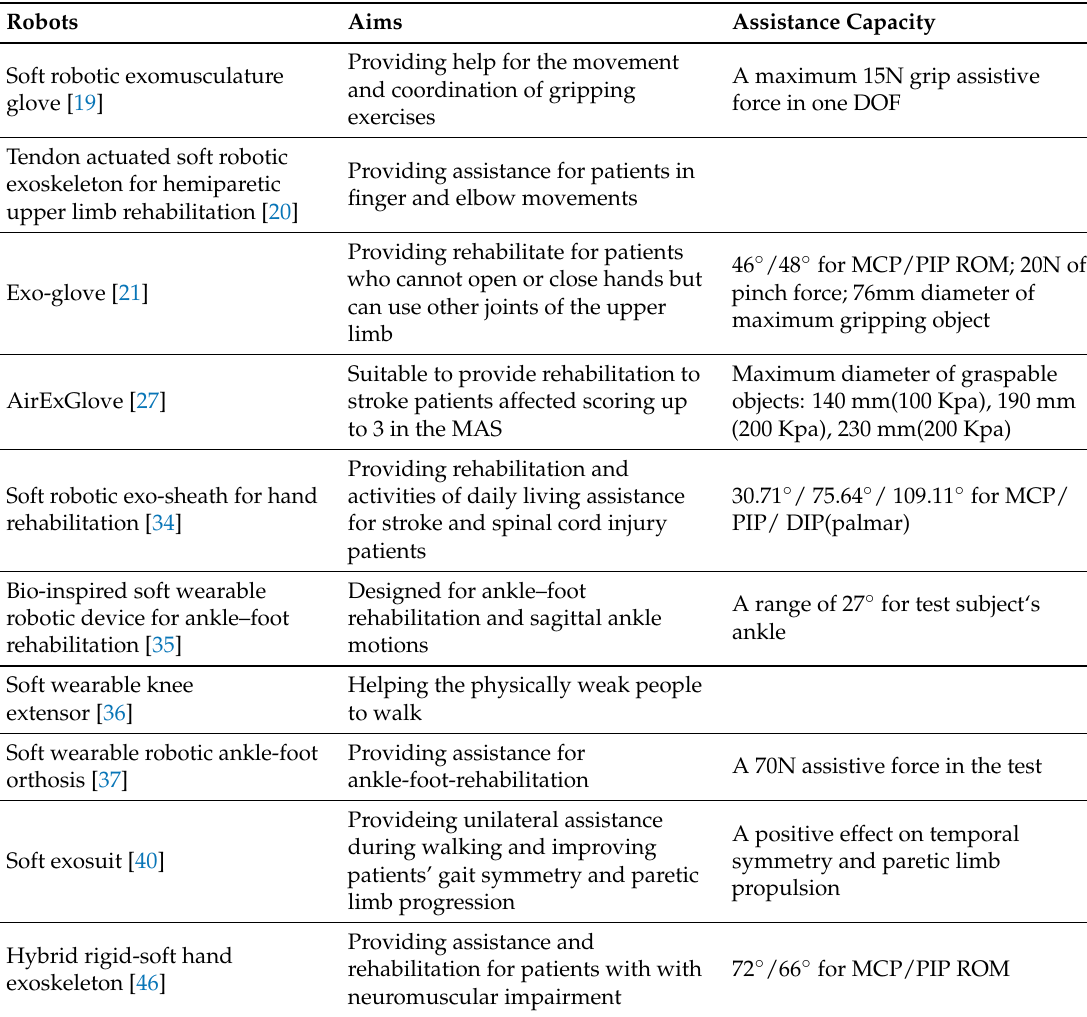
Table 1. Overview of soft rehabilitation and nursing-care robots based on tendon-driven actuation.